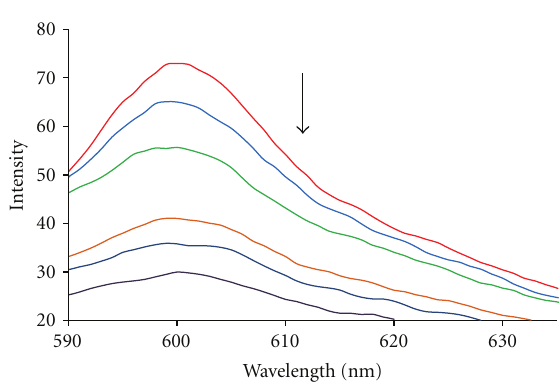
cDNA = 7 . 74 × 10 − 5 M; cNR = 1 . 00 × 10 − 5 M; and c Pt complex = 0.00, 0.25, 0.5, 0.75, 1.00, and 2 . 00 × 10 − 5 M for curves 1–6,